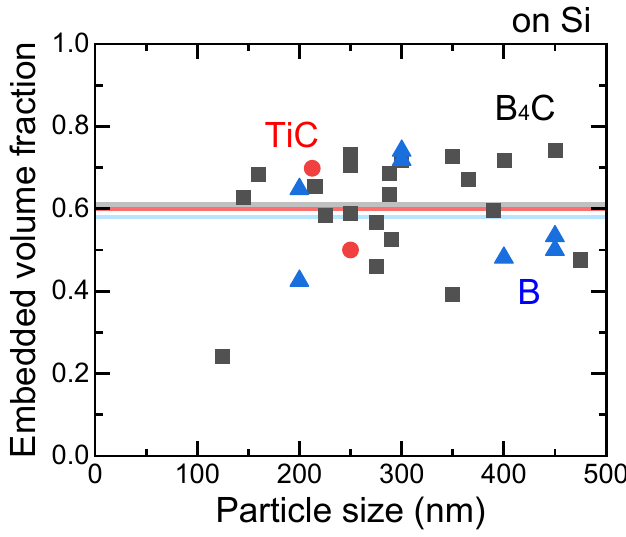
Figure 14. Particle size dependence of embedded volume fraction of TiC (red circles), B 4 C (black squares), and B (blue triangles) on Si substrates. The horizontal lines indicate the average values of the embedded volume fraction of particles with corresponding colors.